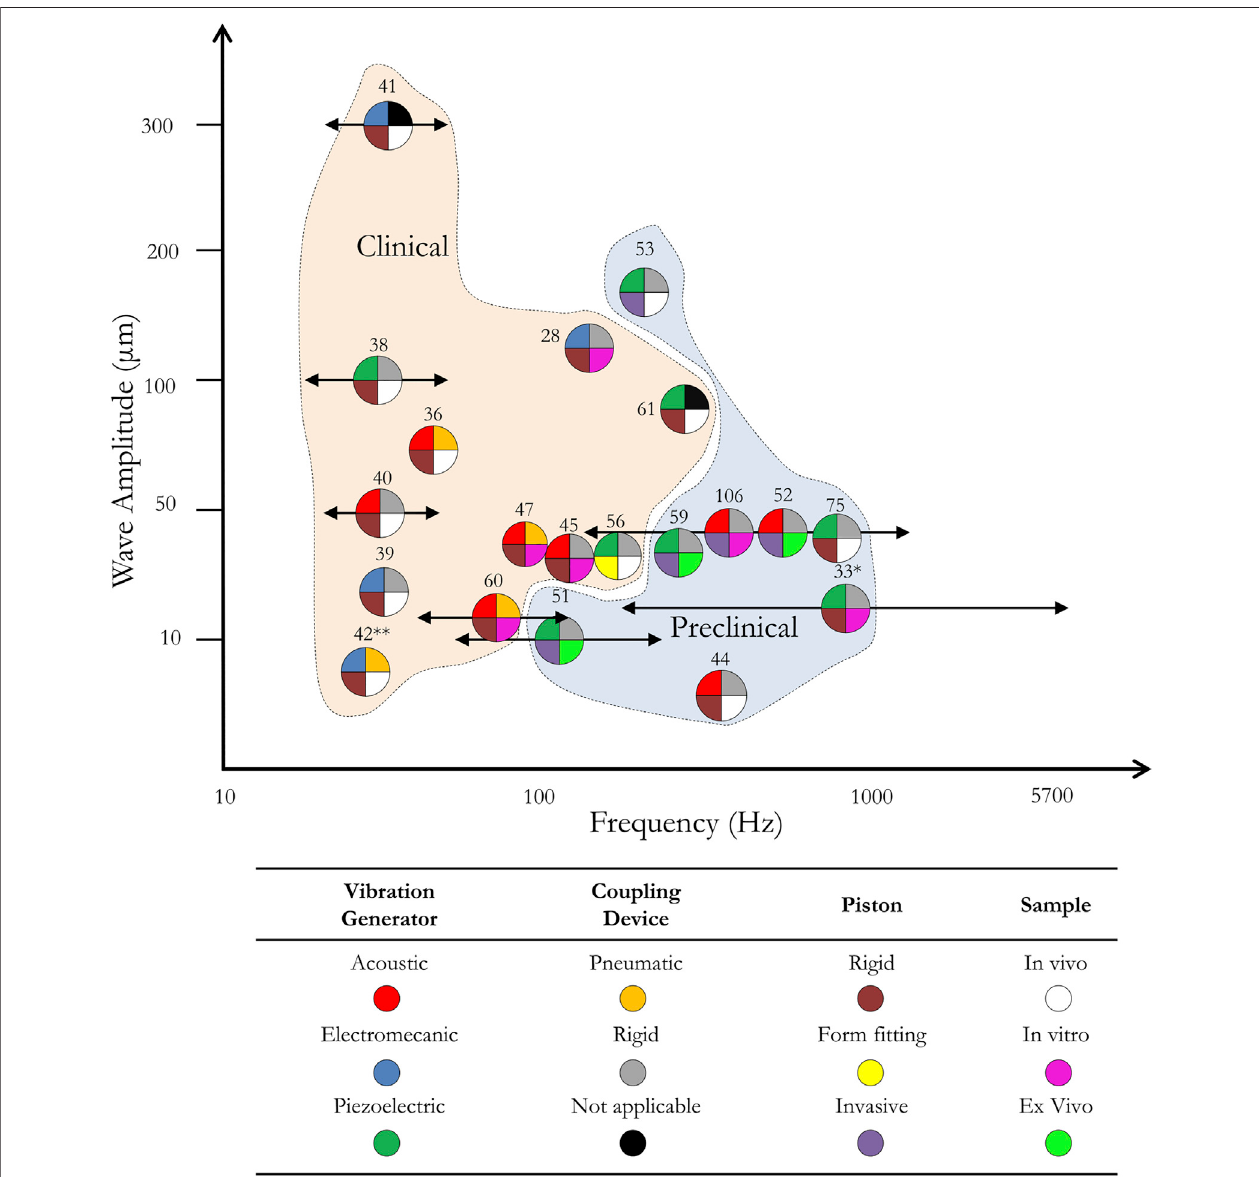
FIGURE 3 | Wave amplitude generated within the sample by mechanical actuators from the literature as a function of the frequency and the application. Each mechanical actuator is represented by a pie chart labelled by a bibliographical reference number and divided in four parts which corresponds to four actuator characteristics: the vibration generator (top left corner) , the coupling device (top right corner) , the piston (bottom left corner) and the type of experiment (bottom right corner) . Each characteristic is divided in three colored categories given in the table. The X -axis shows the frequency at which the MRE experiment was run, and the Y -axis is the wave amplitude within the region of interest. Arrows are introduced for actuators which cover a wide range of frequencies. Clinical and preclinical zones provide information on the type of application the actuators were built for. This graph only shows actuators for which both the amplitude within the tissue and the frequencyinformationwasgiven.(*)here,thecouplingdeviceandthepistonarecombinedinasinglepart.(**)here,thepneumaticcouplingdevicehasbeenreplacedby a hydraulic system.